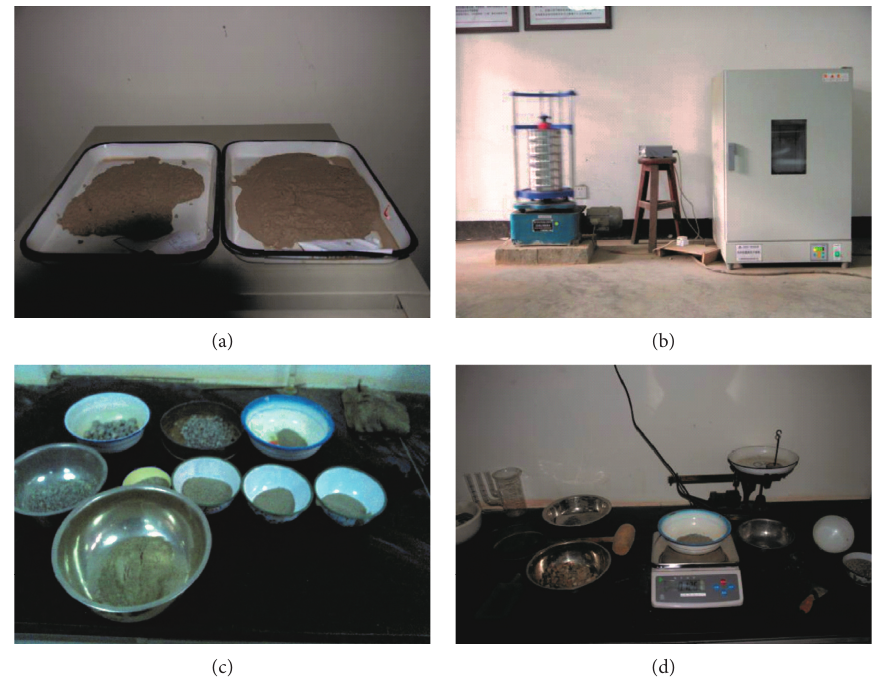
Figure 3: Screening test equipment. (a) Sample classification. (b) Drying and screening. (c) Collection of samples on screen. (d)